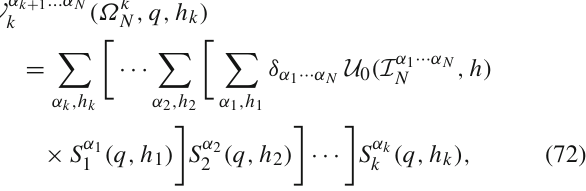
Fig. 4 Diagrammatic representation of helicity sums and diagram merging. Upon taking the interference with the Born amplitude, the helicities of the k dressed segments are summed, and the full set of